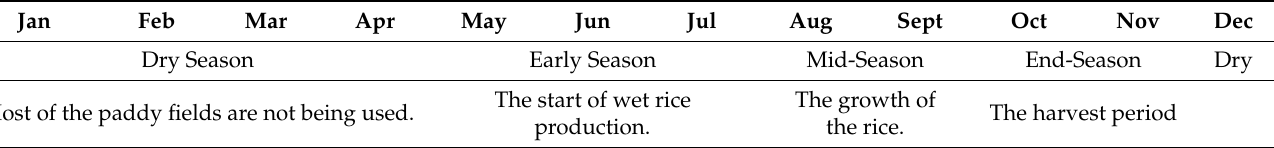
Figure 2. The drought context in Kampong Speu and Pursat Provinces. Table 3. Generic rice cropping calendar and possible drought